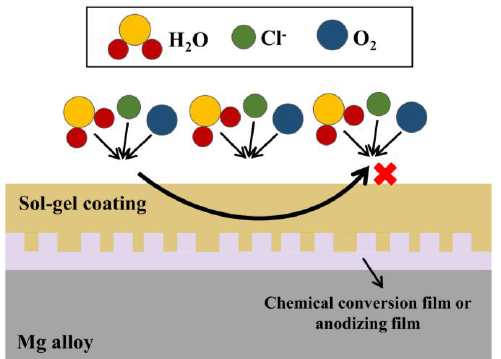
Figure 6. The schematic diagram of the anticorrosion principle of the composite sol-gel